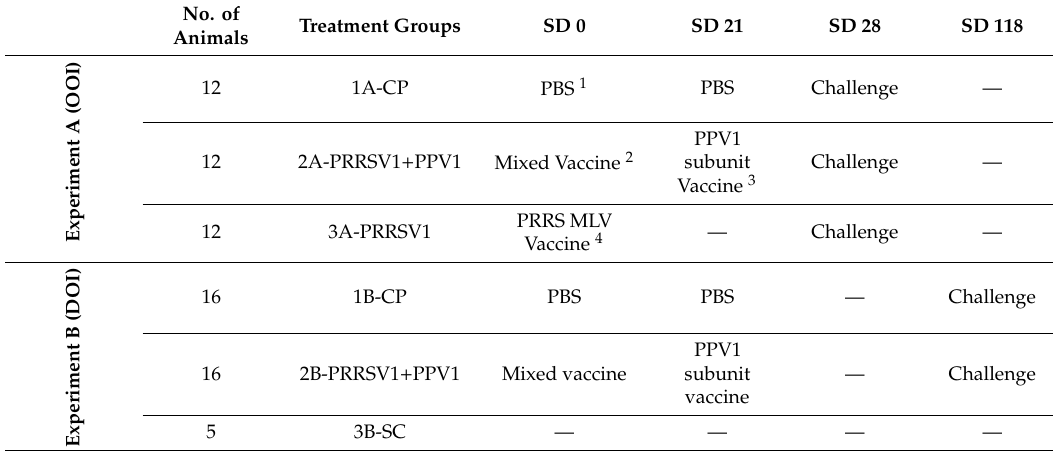
Table 1. Designs of experiment A and experiment B. The enrolled PRRSV naïve gilts were split into three treatment groups in each experiment. Experiment A was terminated 3 weeks after PRRSV1 challenge (SD 49). Gilts from experiment B were estrus synchronized, inseminated, and challenged at approximately 90 days of gestation (SD 118). In this case, the study was terminated 20 days after